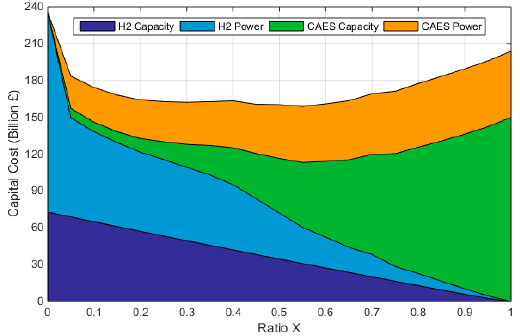
Figure 14. Breakdown of total capital cost required for the energy stores.